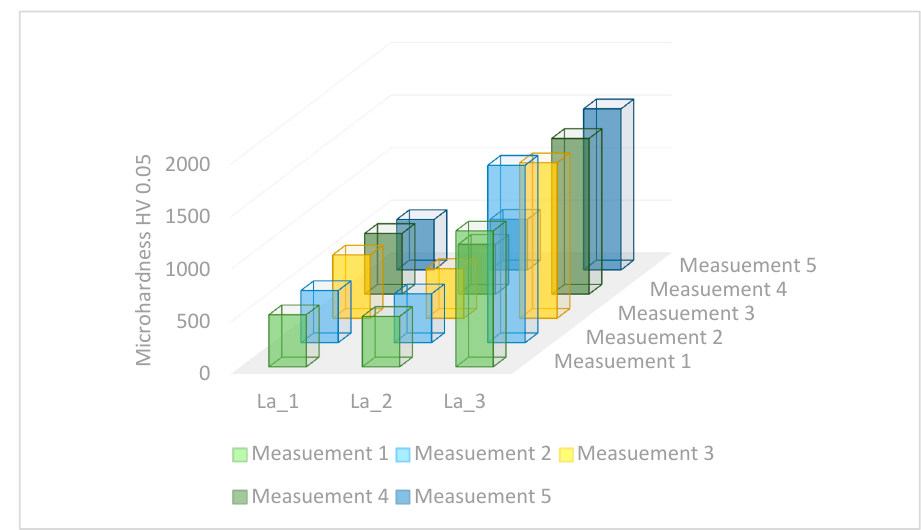
Figure 7. Results of measurements of the microhardness of tapes of the Fe-B-La-Al alloys.